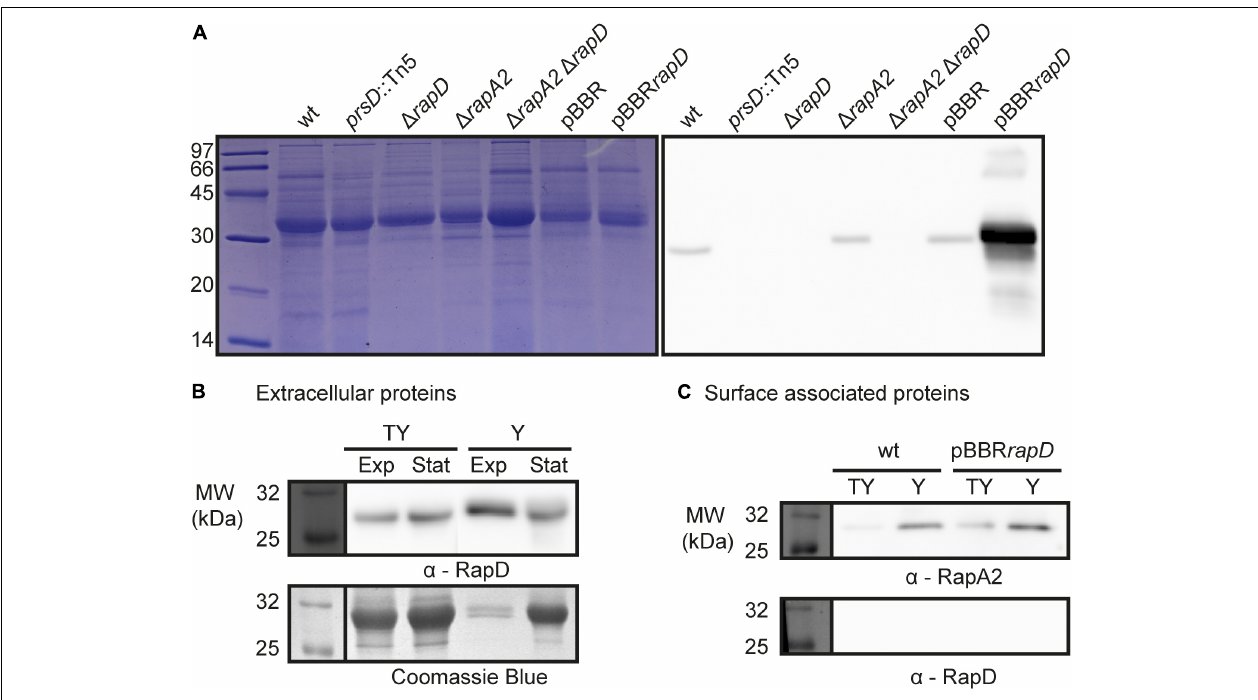
FIGURE 2 | RapD secretion: PrsDE dependence and final destination. (A) Extracellular proteins of spent cultures from several Rlv. 3841 isogenic strains were analyzed by 15% SDS-PAGE and Western blot. Immunodetection of secreted RapD was revealed by specific anti-RapD antiserum revealed by an anti-mouse HRP conjugated secondary antibody. (B) RapD secretion in nutrient-rich (TY) and deprived (Y) conditions. Western blot analysis of extracellular proteins from exponential phase [OD 600 nm = 0.7 (TY) and 0.8 (Y)] and late stationary phase [OD 600 nm = 1.2 (TY) and 1.5 (Y) cultures are shown]. (C) Surface-associated proteins from exponential phase cultures of Rlv 3841 wild type strain and a RapD overexpressing strain cultured in rich (TY) and minimal (Y) medium. Western blot was revealed using polyclonal antisera against RapA2 or RapD and a HRP conjugated secondary